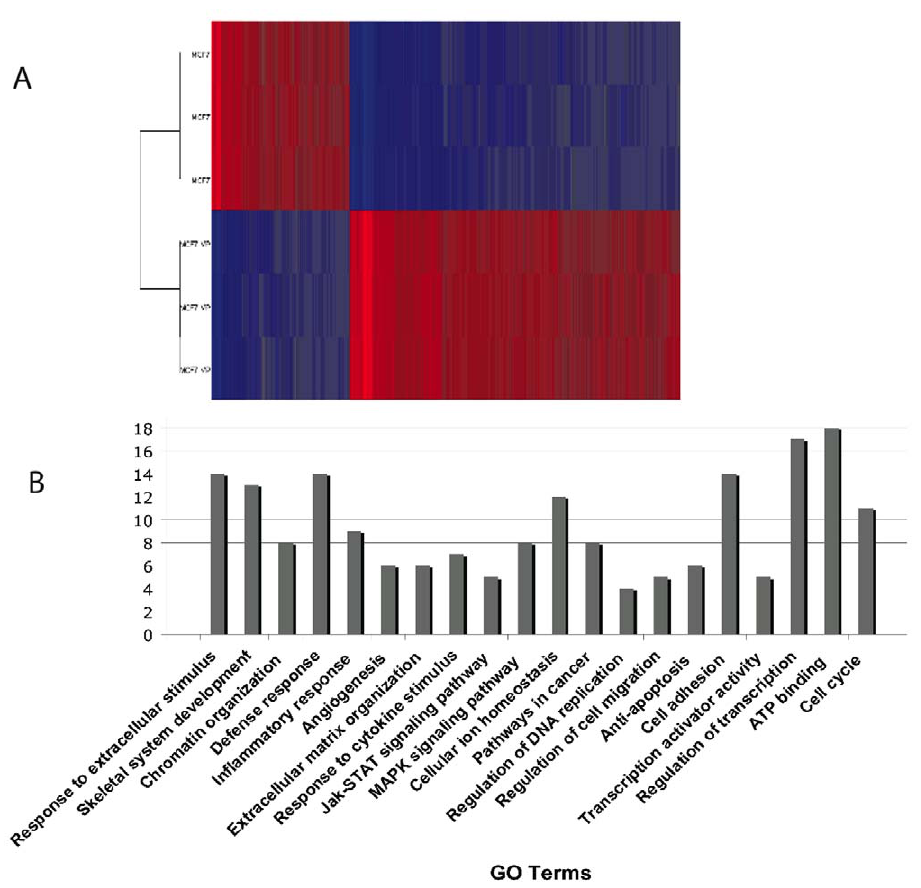
Figure 4. Gene expression microarray data and GO analysis revealed differential gene expression between MCF7 & MCF7VP cell lines. Figure 4A. Heatmap depicting differential gene expression in etoposide resistant and etoposide sensitive MCF7 cells using Affymetrix U133 arrays ( . 2fold change in expression, p , 0.05). Up-regulated genes depicted in red, down-regulated genes in blue (see color bar). Fig. 4B. DAVID analysis of microarray data depicting the number of genes expressed in different cellular mechanisms and pathways (Top 219 genes, p ,